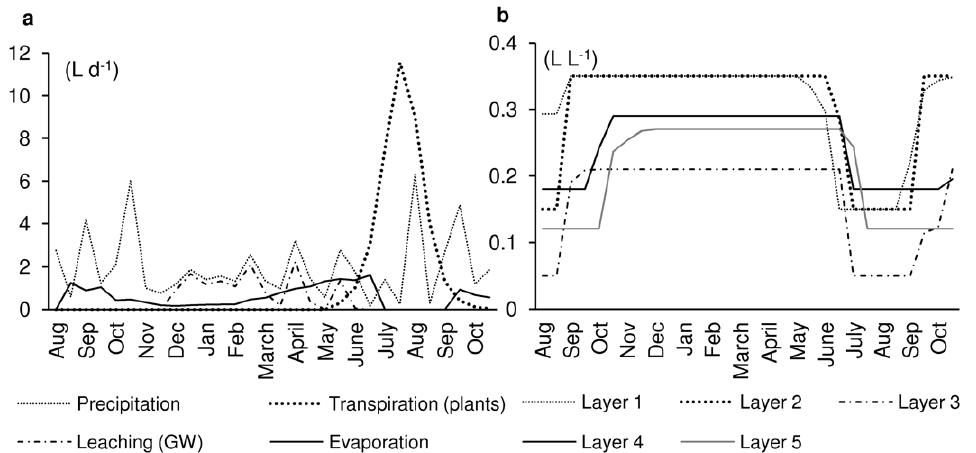
Figure 4. Simulated water balance and content of soil. (a) Simulated annual water balance, control scenario, August 1998 to October 1999; (b) simulated water content of the five soil layers, same simulation event.